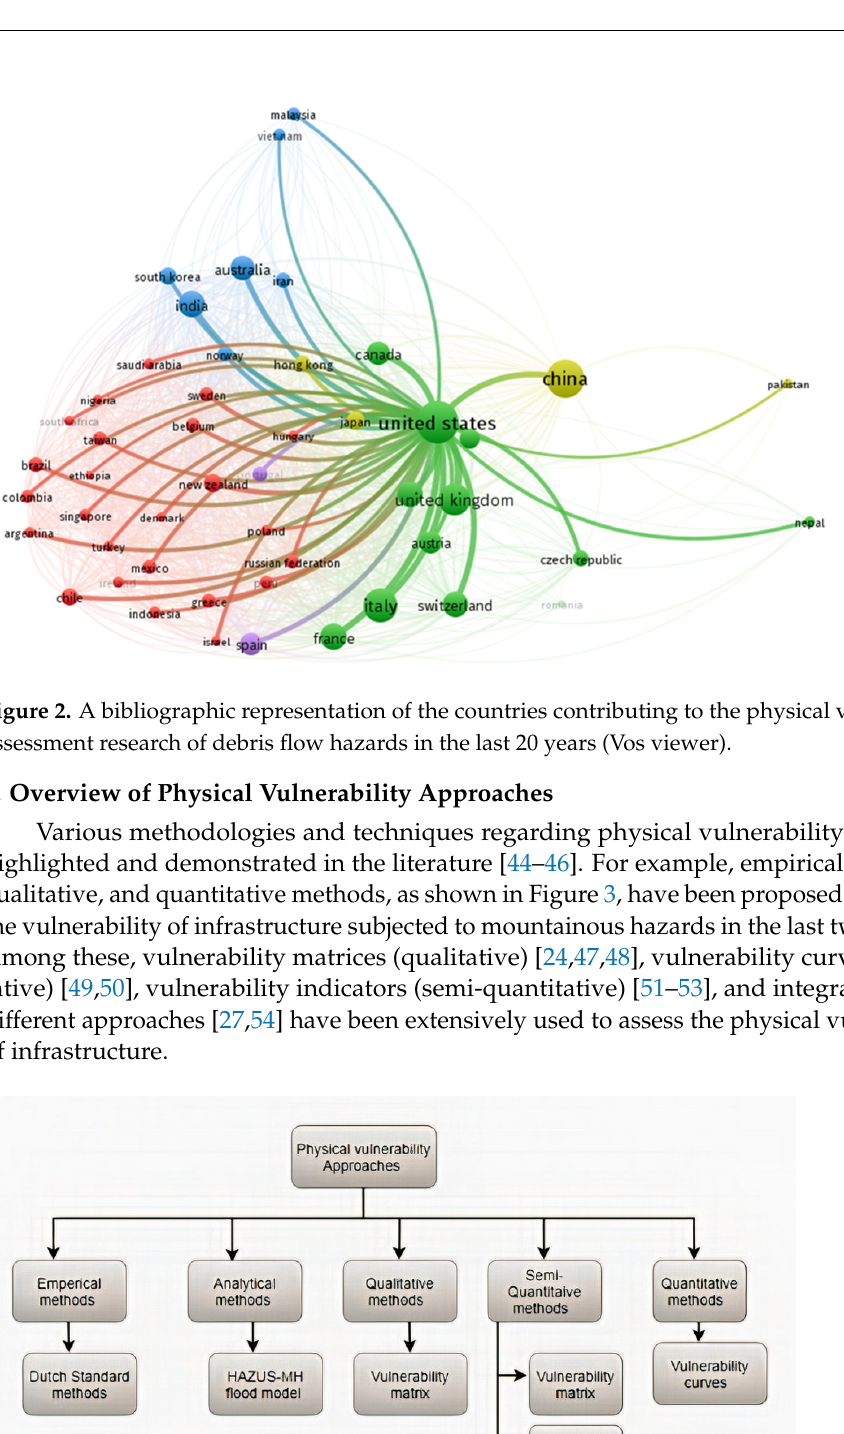
Figure 3. Different types of physical vulnerability approach.